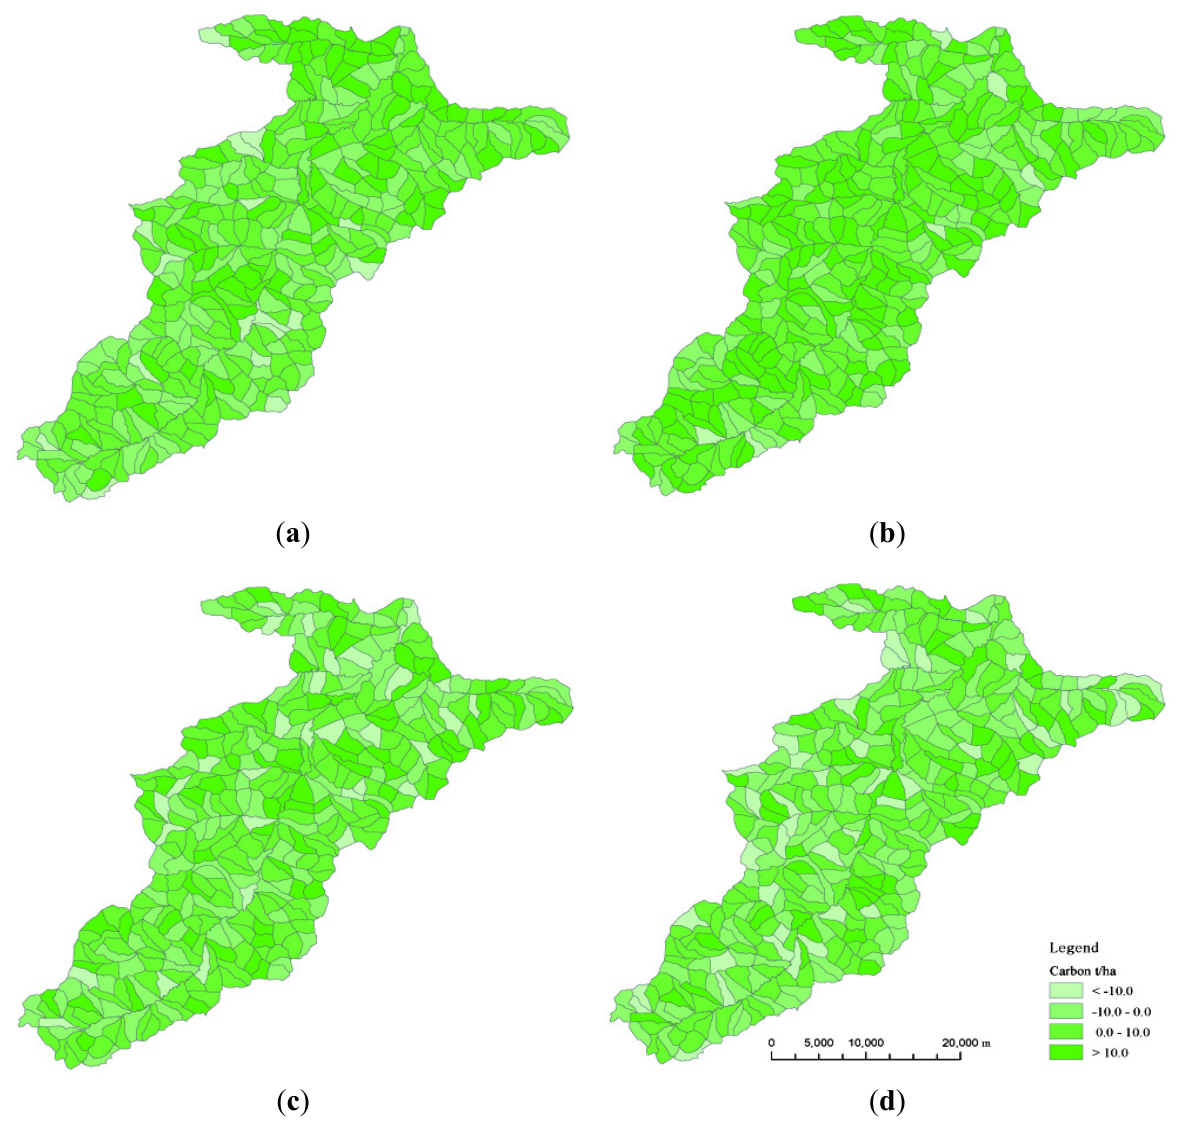
Figure 5. Changes in forest carbon levels for the four forest landscapes with different age class distributions; ( a ) actual forest; ( b ) young forest; ( c ) normal forest; ( d ) older